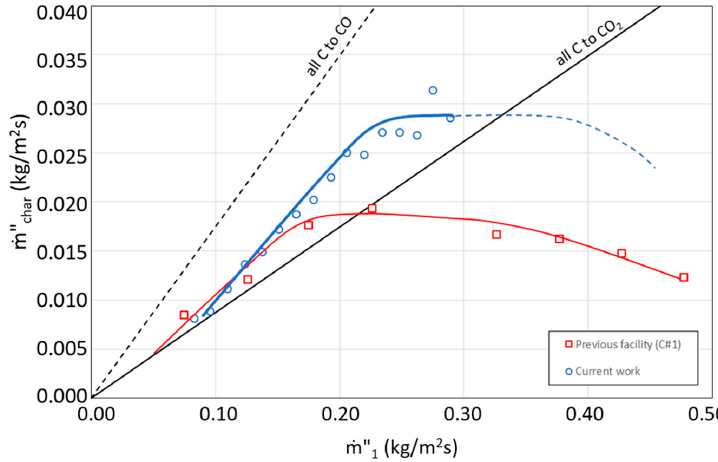
Figure 9. Comparison of the char burning rates using only primary air for different facilities.